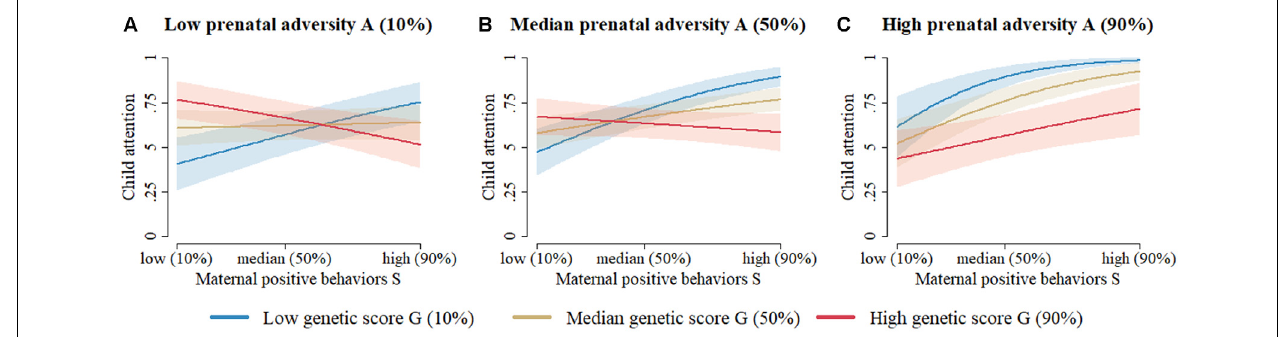
FIGURE 1 | The prediction of toddler attentional competence at 18–24 months based on the two-way interaction model ( Table 4 ) without missing data imputation and without variable selection (column 1). (A) When prenatal adversity is low, attentional competence of young children with low dopaminergic genetic scores increases from low to high with increasingly positive early maternal parenting behavior. Meanwhile, children with moderate or high dopaminergic genetic scores start at a relatively high level of attentional competence, which seems to be unaffected by an increase in early positive maternal parenting behaviors. (B) When prenatal adversity is moderate, young children with low dopaminergic genetic scores start at moderate levels of attentional competence, which rapidly increases as positive early maternal parenting behavior increases. Meanwhile, children with moderate or high dopaminergic genetic scores start at a high level of attentional competence, which seems to be unaffected by an increase in early positive maternal parenting behaviors. (C) When prenatal adversity is high, young children with low dopaminergic genetic scores start at a high level of attentional competence, which seems relatively unaffected by increasingly positive early maternal parenting behaviors. Children with moderate dopaminergic genetic scores initially have moderate levels of attentional competence, which increases linearly as positive early maternal parenting behavior increases. Children with high dopaminergic genetic scores initially have low levels of attentional competence, which also increases linearly as early positive maternal parenting behaviors increase. Note . Figures for the two-way interaction models with/without imputation and with/without variable selection all look very similar. Note 2 . Despite the absence of a three-way interaction effect, results must be graphically represented similarly to a three-way interaction model, since all three main components (i.e., G, E 1 , and E 2 ) interact with one another in two-way interactions within the same